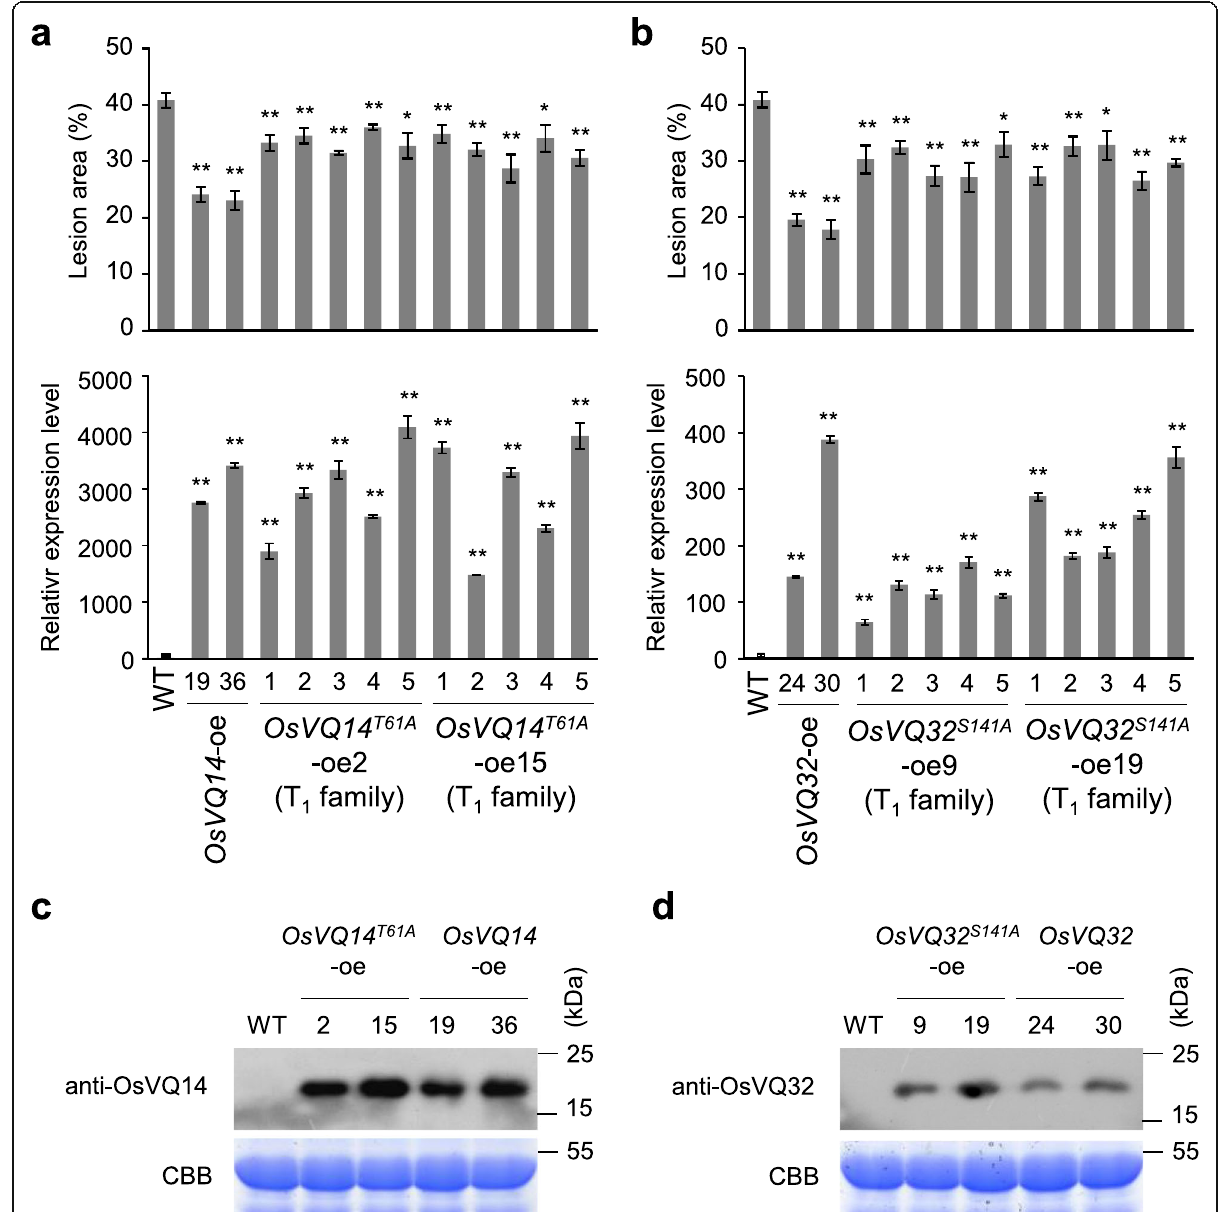
Fig. 5 OsVQ14 and OsVQ32 phosphorylations by OsMPK4 contributed to rice resistance to Xoo . Bars represent mean (4 to 5 leaves for lesion area and 3 replicates for gene expression) ± SD. The asterisks “ ** ” or “ * ” indicates a significant difference between transgenic plants and WT plants at P < 0.01 or P < 0.05. a Analyses of lesion area and OsVQ14 expression level of OsVQ14 -oe and OsVQ14 T61A -oe transgenic plants. b Analyses of lesion area and OsVQ32 expression level of OsVQ32 -oe and OsVQ32 S141A -oe transgenic plants. c Analysis of OsVQ14 accumulation of OsVQ14 -oe and OsVQ14 T61A -oe transgenic plants. d Analysis of OsVQ32 accumulation of OsVQ32 -oe and OsVQ32 S141A -oe transgenic